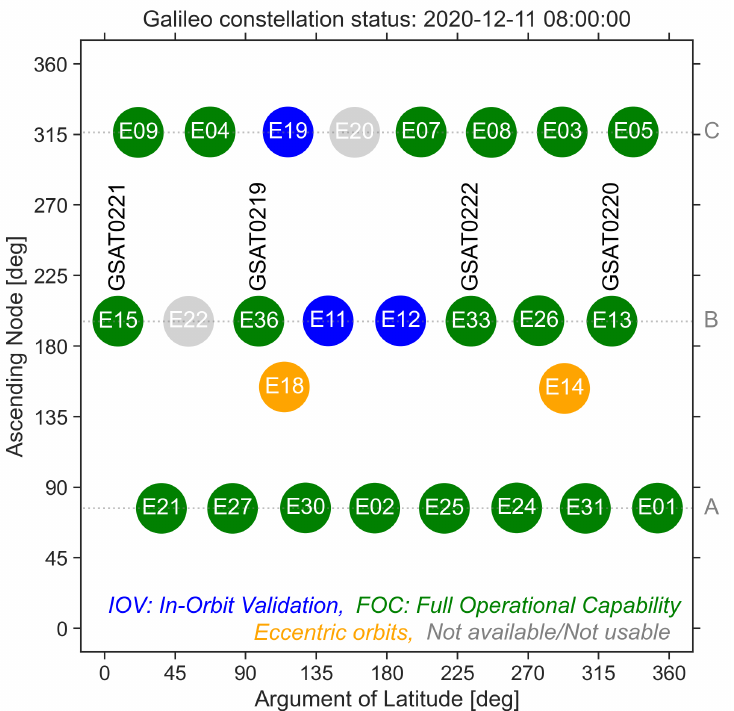
Figure 1. Position of the Galileo L10 satellites within the entire Galileo constellation. The satellites are arranged in three orbital planes depicted by the capital letters (A,B,C) on the the right hand side. Different colours are used to denote the type of the satellites: IOV, In-Orbit Validation (blue), FOC, Full Operation Capability (green), satellites in eccentric orbits (orange) and not available/not usable satellites